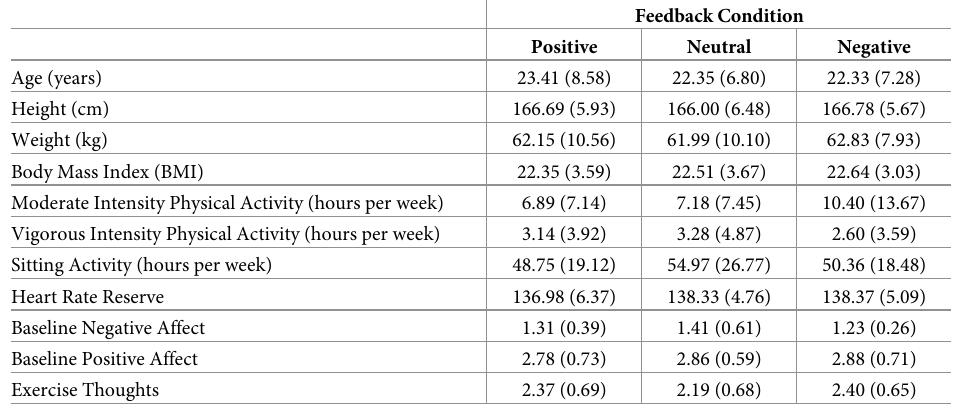
Table 1. Means (standard deviations) for participant descriptive variables in each feedback